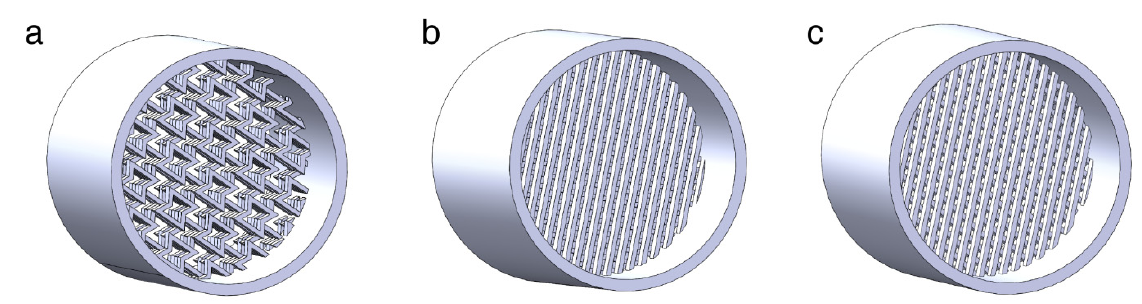
Figure 4. Three different patterns of fluid simulation models with concave hexagon ( a ), triangle ( b ), and orthogonal ( c ) .